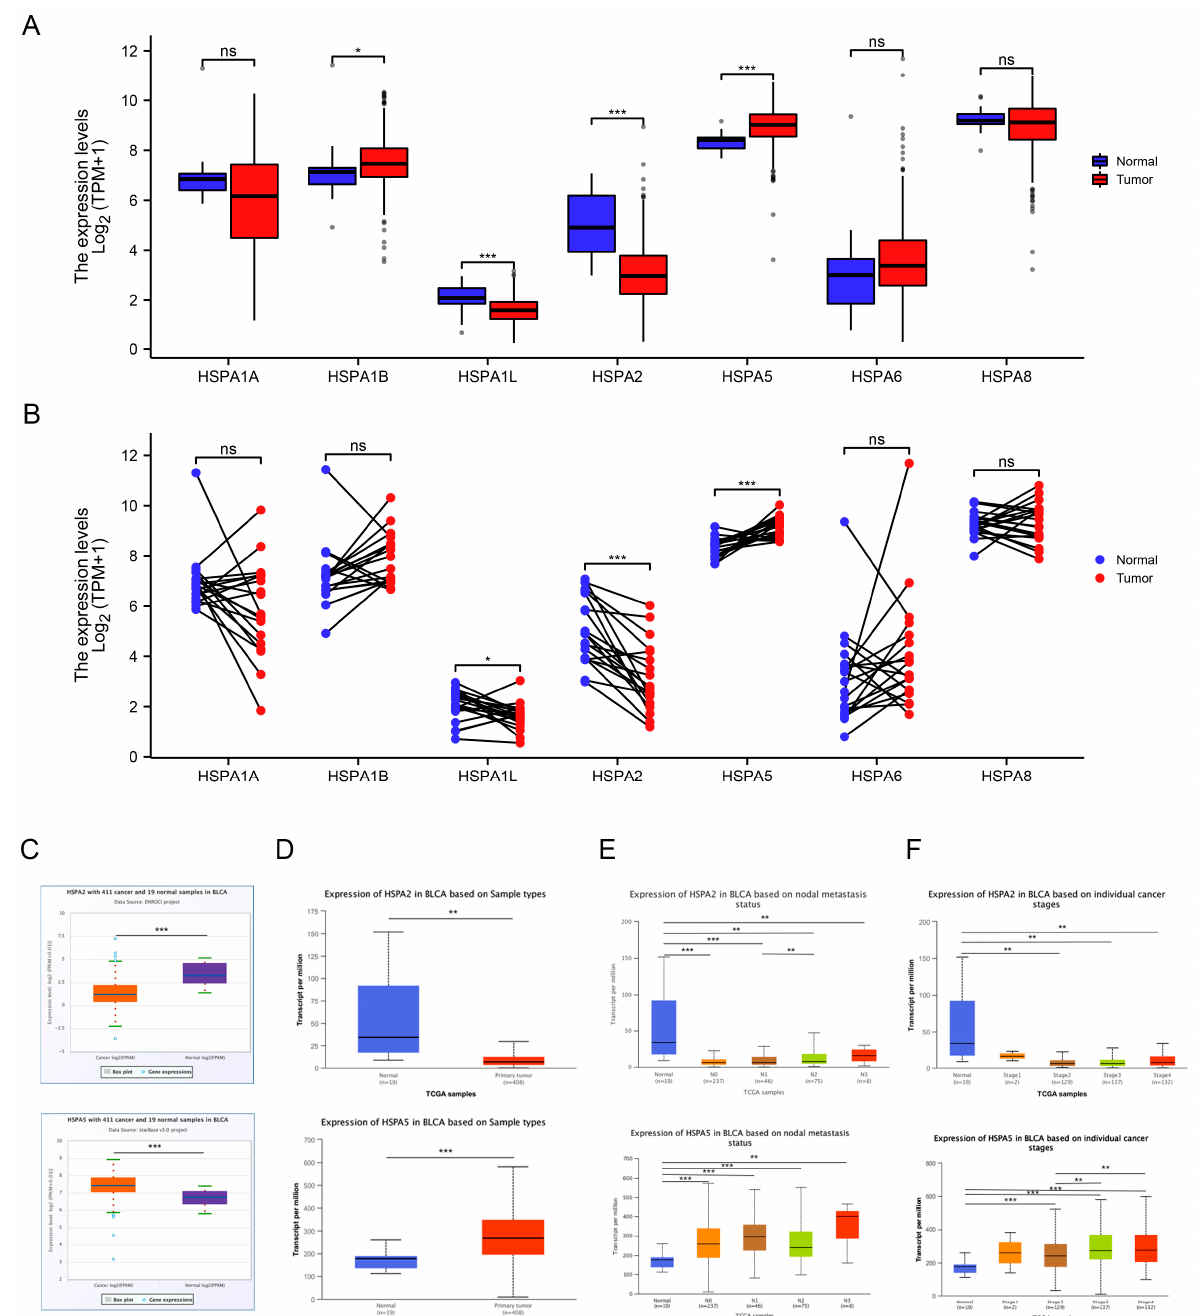
Figure 1. The expression levels of HSP70s in BCa. ( A , B ) Expression of HSP70s from unpaired and paired BCa samples from The Cancer Genome Atlas (TCGA) database. ( C , D ) Expression of HSPA2 and HSPA5 in BCa from starBase (https://starbase.sysu.edu.cn/) (accessed on 4 January 2022) and UALCAN (http://ualcan.path.uab.edu/analysis.html) (accessed on 4 January 2022). ( E , F ) The relationship between protein expression and nodal metastasis status or individual cancer stage. All data are presented as the means ± SD. * p < 0.05, ** p < 0.01, *** p < 0.001.